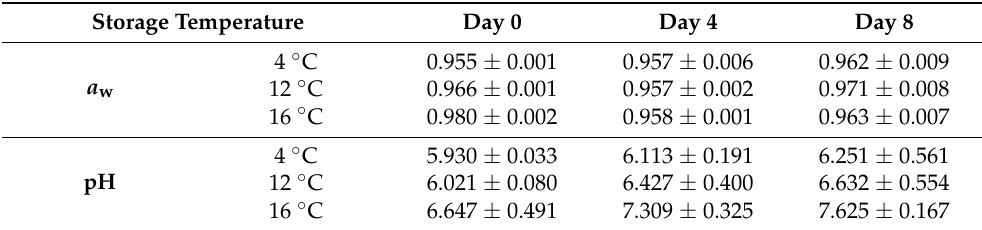
Table 2. Average and standard deviation for a w and pH values obtained in ready-to-eat (RTE) salads at 4 ◦ C, 12 ◦ C, and 16 ◦ C throughout the eight days of